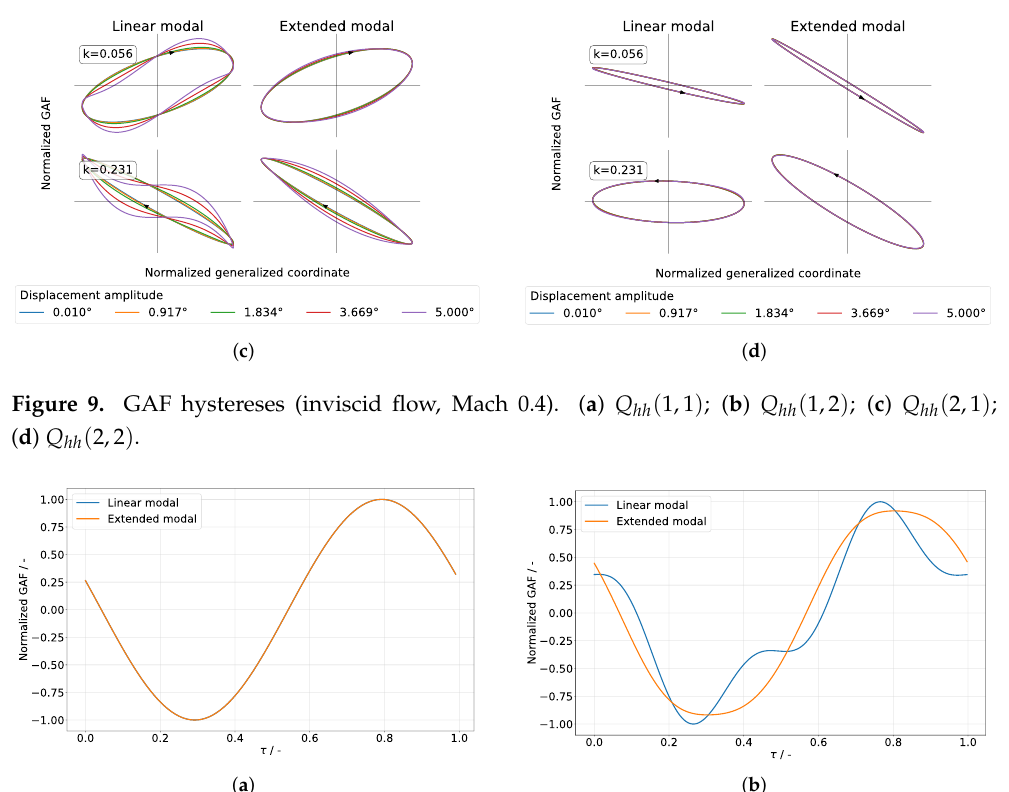
Figure 10. Time history of Q hh ( 2,1 ) for one period of oscillation (Inviscid flow, Mach 0.4, reduced frequency 0.231): ( a ) 0.01° roll motion amplitude; ( b ) 5.0° roll motion